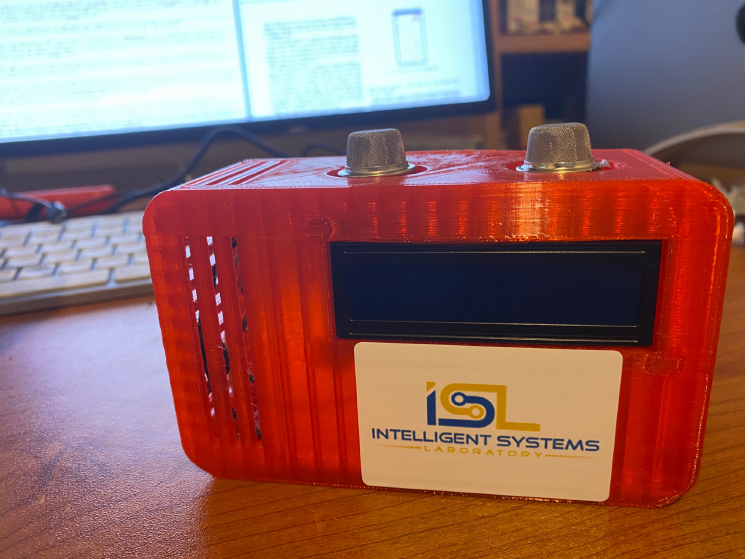
Figure 2. The TinyML-based system for gas